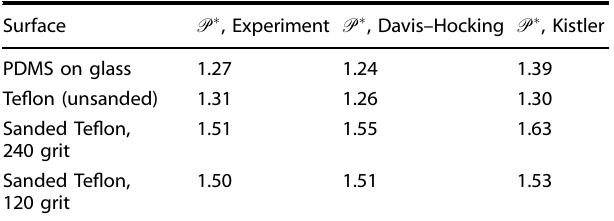
Table 6. Cumulative projected swept areas (normalized) for experiment and simulation.